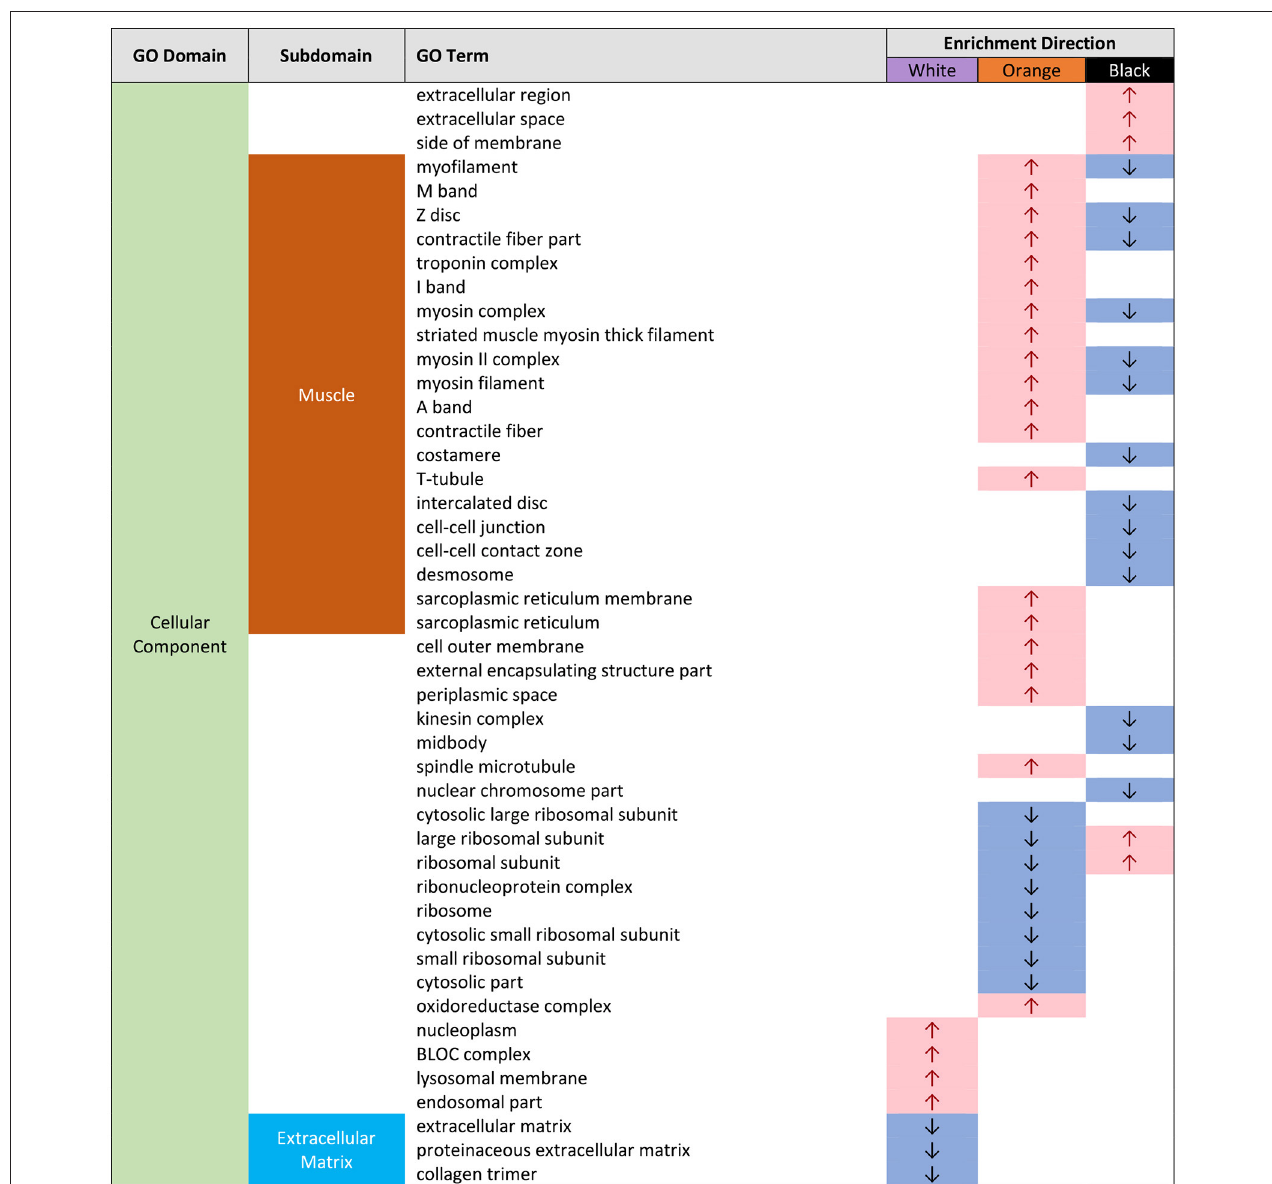
FIGURE 3 | Gene ontology (GO) categories significantly enriched for both pairwise color comparisons for each epidermal tissue by “cellular component” (CC) using Mann-Whitney U tests based on ranking of signed log p -values computed using EdgeR . Results indicate the GO domain (CC), the subdomains discussed in text (“muscle” and “extracellular matrix”), the specific GO terms, and enrichment direction observed consistently in each epidermal tissue